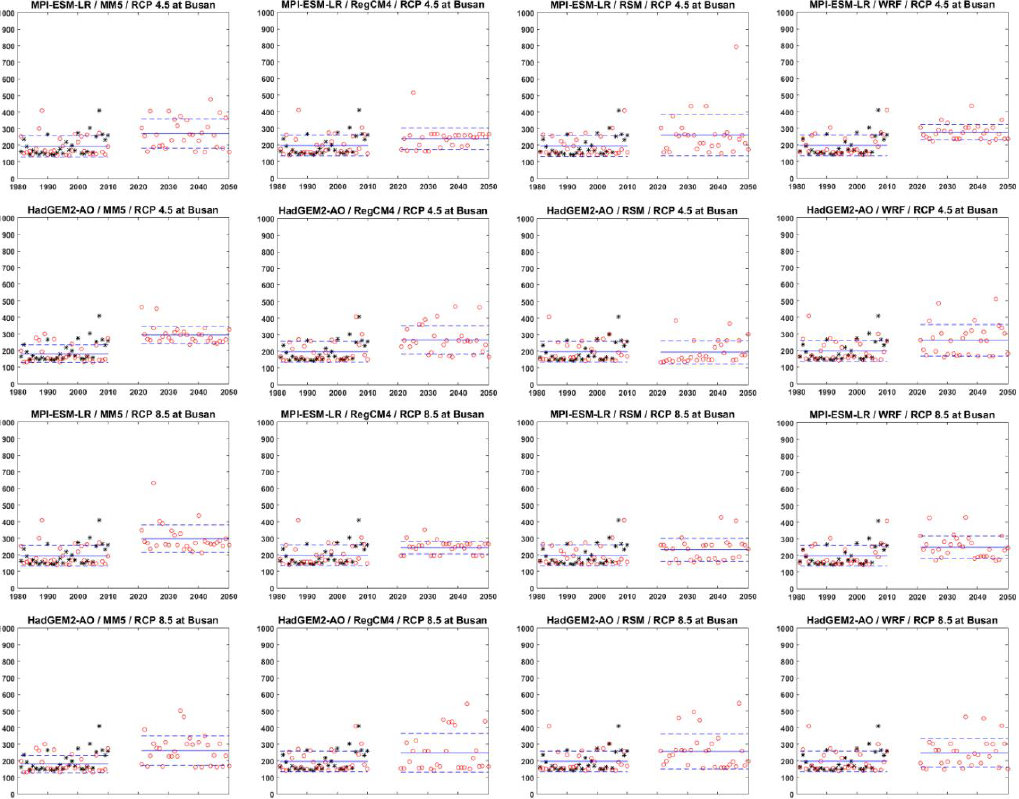
( c ) RCP 8.5 Figure 14. Sensitivity of annual exceedance daily rainfall depth to SAT. ( a ) Present ( b ) RCP 4.5 ( c ) RCP 8.5 Figure 15. Sensitivity of annual exceedance daily rainfall depth to DPT. As can be seen in Figures 14 and 15, both SAT and DPT were found to be relatively well reproducible for the sensitivity obtained from the observational data. This means that analyzing future extreme daily rainfall depth using SAT and DPT data derived from climate models can be somewhat reliable.